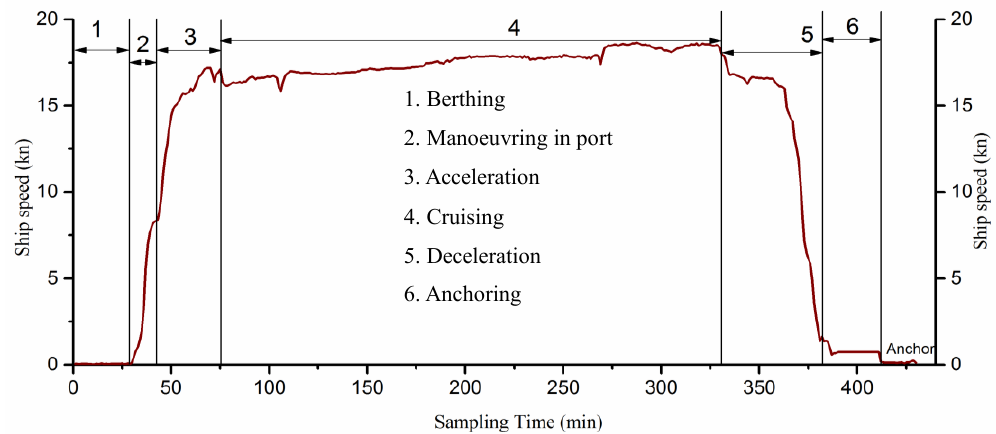
Figure 3. Distribution of the operating conditions of the seagoing ship.